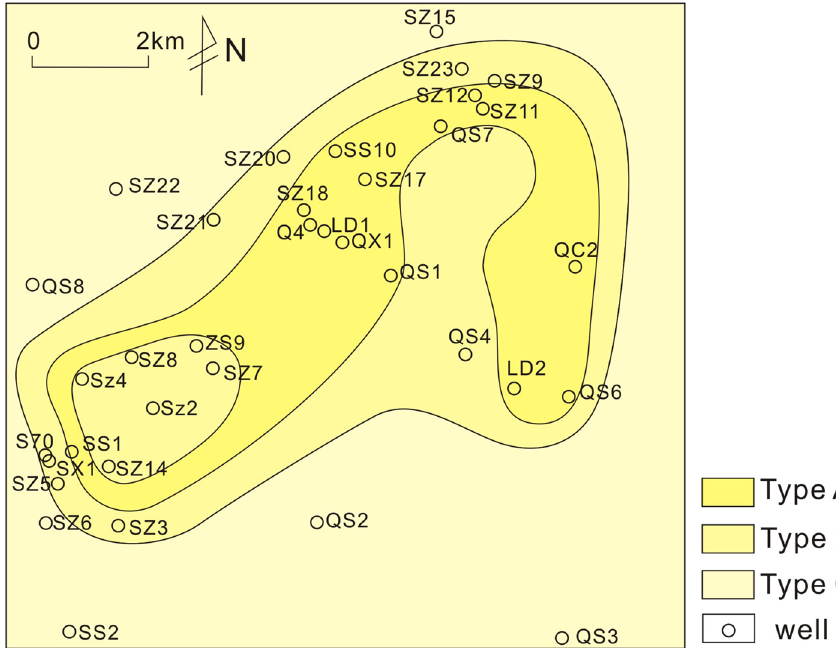
Fig. 13 The distribution of sandstone reservoir types of the Oligocene Xiaganchaigou Formation (E 3 ) in the Lengdong area, Qaidam